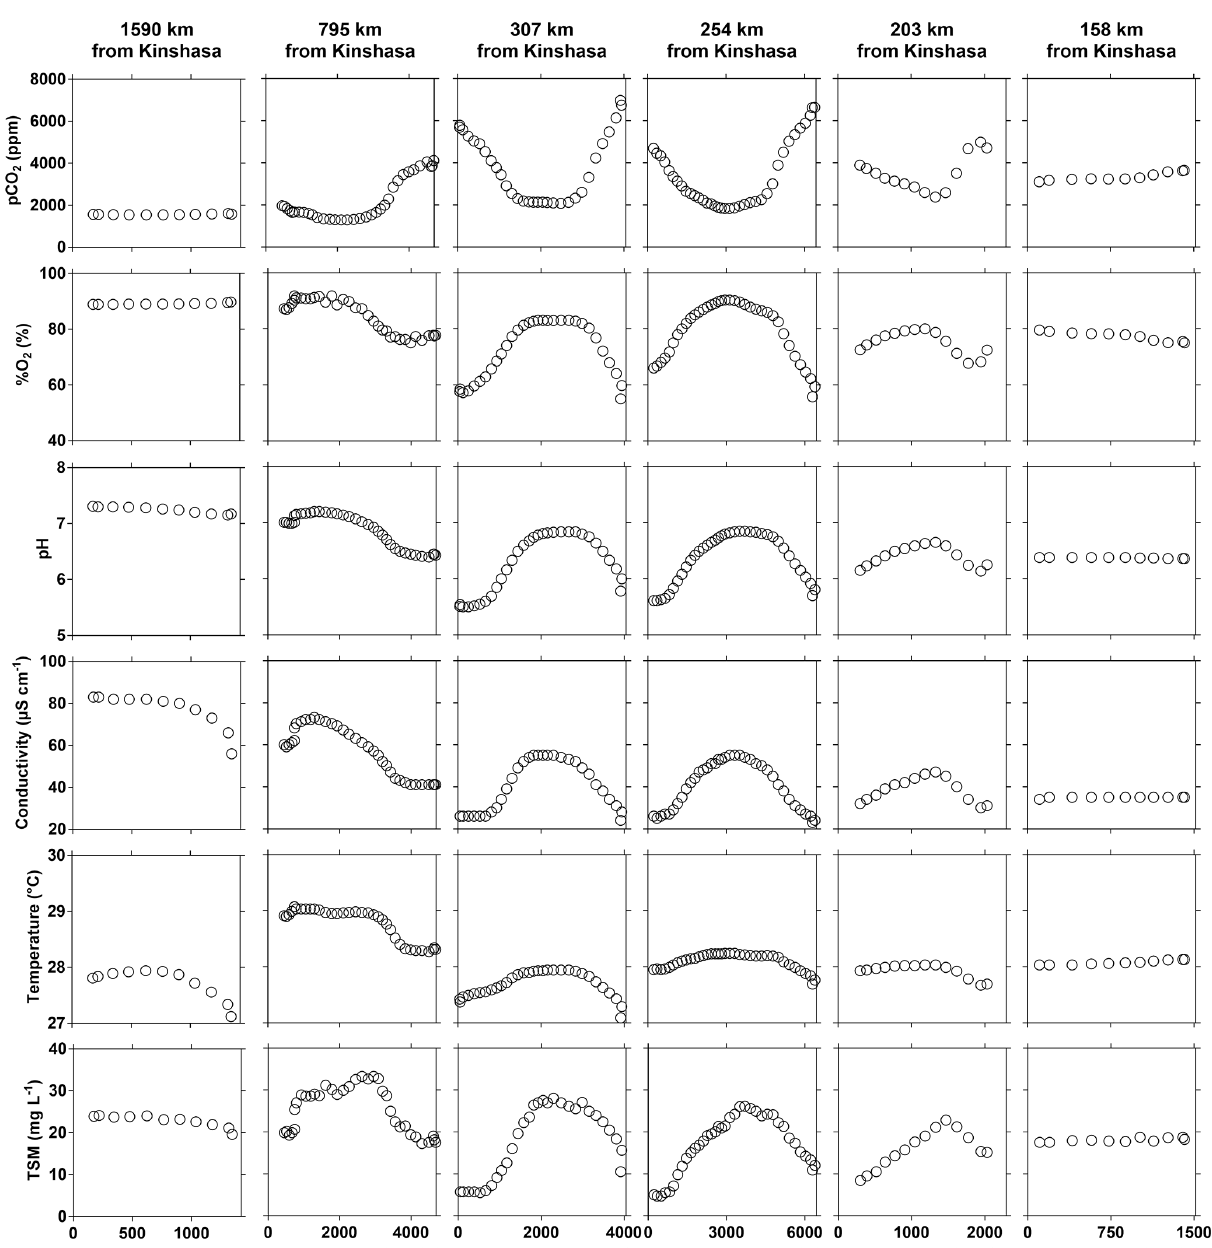
Figure 9. Variations in surface water of the partial pressure of CO 2 ( p CO 2 inppm), dissolved oxygen saturation level (%O 2 in %), pH, specific conductivity (µScm − 1 ), water temperature ( ◦ C) and total suspended matter (TSM in mgL − 1 ) along perpendicular transects to the main stem Congo River as a function of distance from the left bank (m) and at a variable distance from Kinshasa (10–30 June